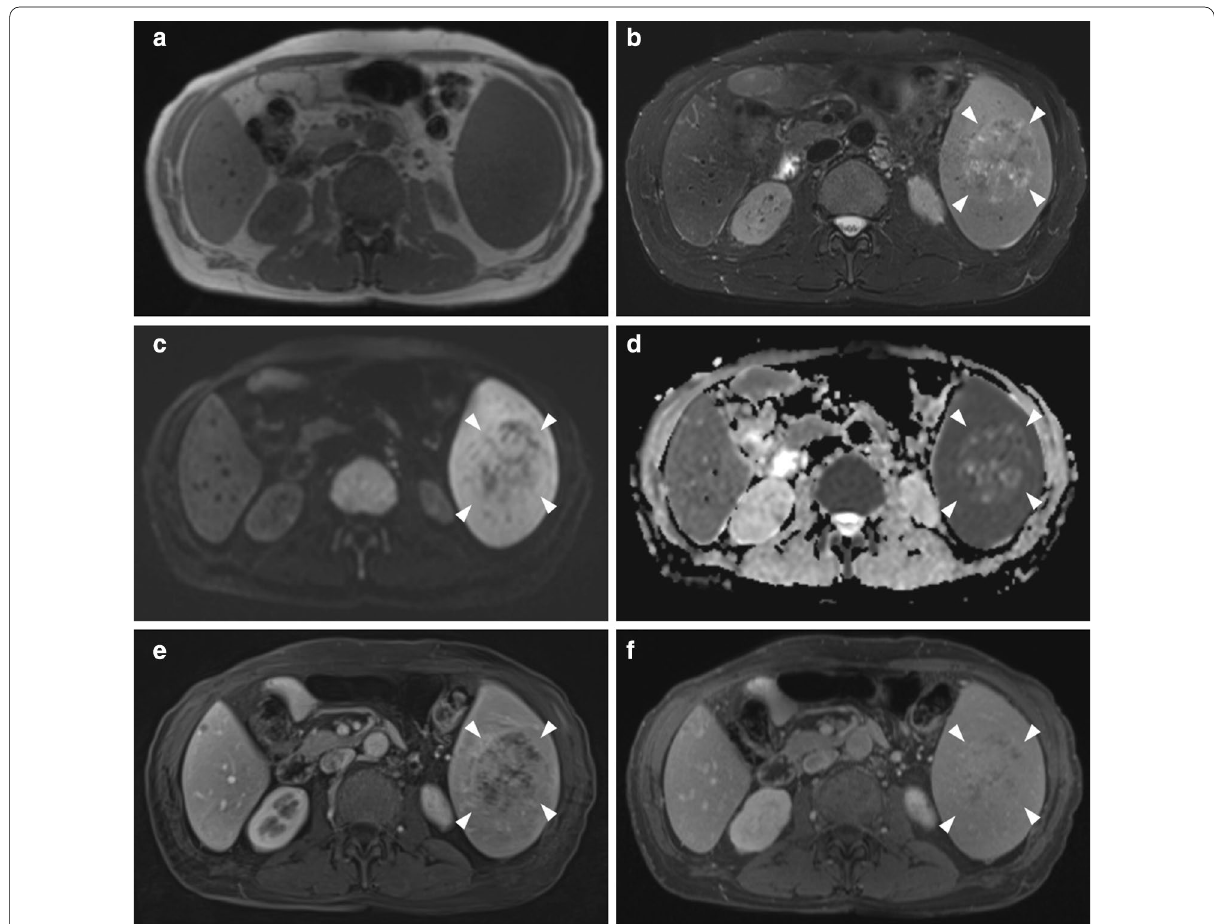
Fig. 2 Magnetic resonance imaging of the tumor. Magnetic resonance imaging showed that the tumor signal was iso-intense on T1-weighted imaging a and exhibited a mottled high-intensity on T2-weighted imaging ( b arrowheads), low-intensity on diffusion-weighted imaging ( c arrowheads), and high-intensity on apparent diffusion coefficient mapping ( d arrowheads). Dynamic studies revealed an enhancement